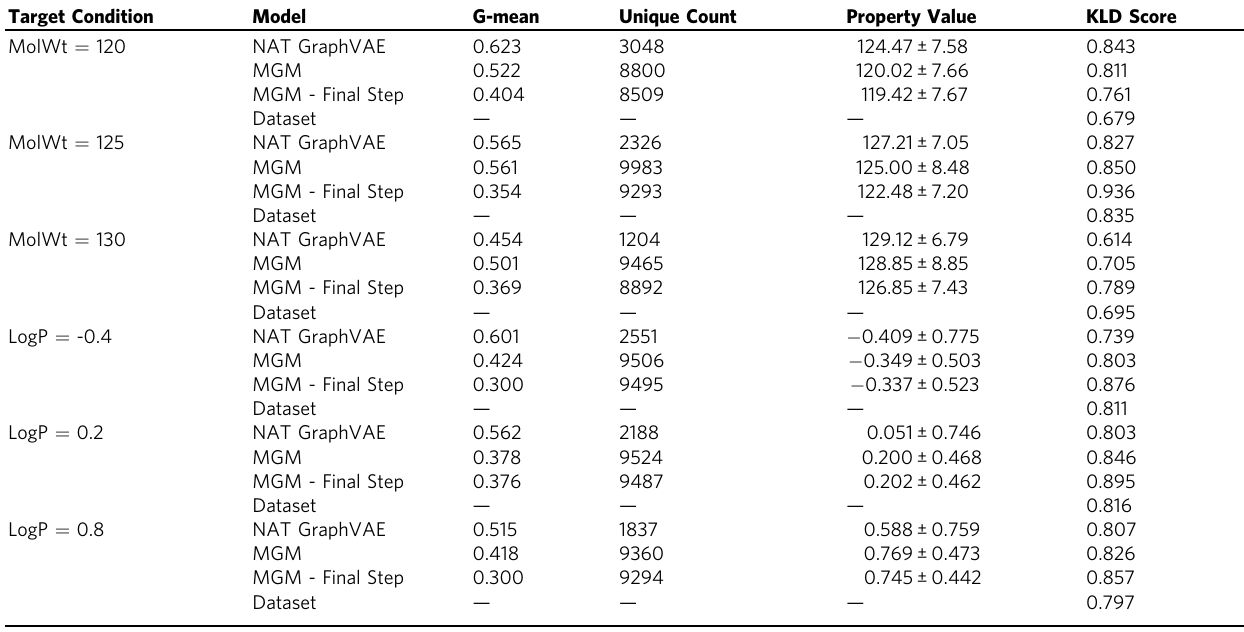
Table 5 Conditional generation results on QM9. Results for MGM are chosen from a range of sampling iterations and both initialization strategies.